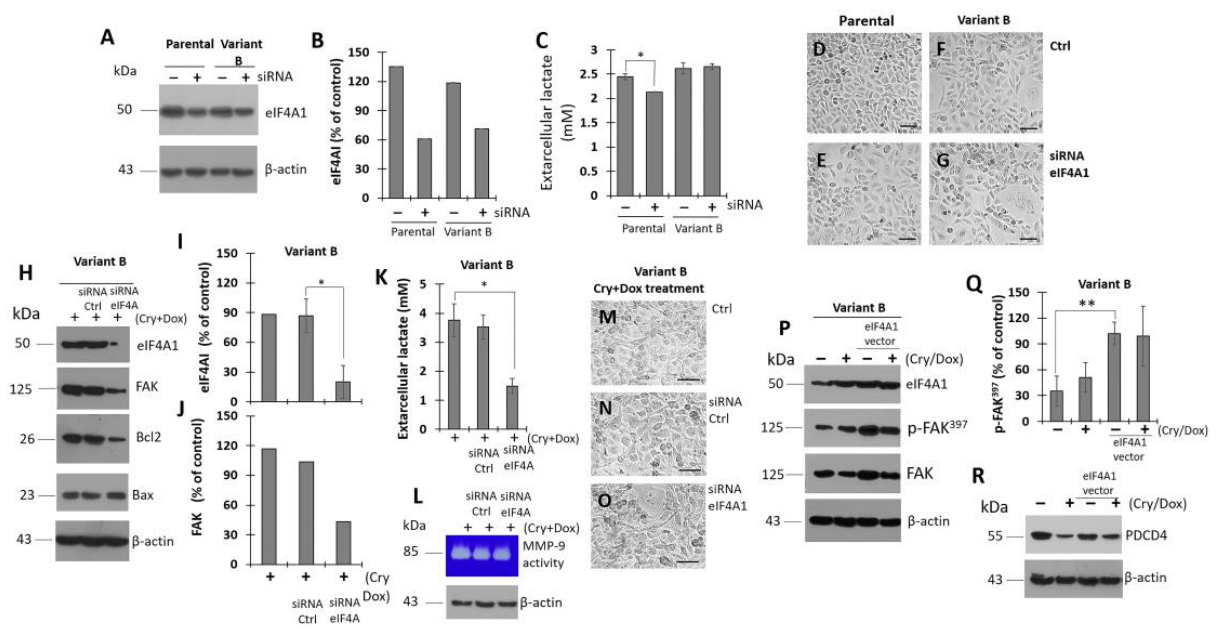
Figure 7. Regulation of eIF4A on FAK is inhibited by concomitant treatment of Dox and Cry. Efficiency of siRNA incubation (80 nM) on the expression of eIF4A1 in parental and variant B at 24 h. ( A ) WB of eIF4A1 in parental cells and variant B and densitometry analysis of eIF4A1 ( B ); ( C ) under the same conditions, lactate concentrations in supernatant media, results are reported as mean ± SD (n = 3), * p < 0.01, respect to control. Optical microscopy images corresponding to control ( D ) and siRNA-eIF4A treated parental cells ( E ); for variant B, control cells ( F ) and siRNA-eIF4A1 treatment ( G ). In controls, the transfection vehicle was evaluated. Bars correspond to 200 µ m. ( H ) Effect of siRNA-eIF4A1 on the expression of FAK, Bcl2 and Bax under the concomitant treatment of Cry (25 µ M) and Dox (500 nM) for 60 h in variant B; densitometry analysis of eIF4A1 ( I ) and FAK ( J ), results are reported as mean ± SD (n = 3) and expressed as % of control; * p < 0.01 respect to control. Under the same transfection conditions and concomitant Cry and Dox treatment, evaluation of lactate in supernatant media (* p < 0.01 respect to control) ( K ), MMP-9 activity ( L ), and representative cellular images of control ( M ), siRNA control ( N ), and eIF4A1-siRNA ( O ). Bars correspond to 200 µ m. ( P ) Effect of the eIF4A1 overexpression on FAK expression and activity (p-FAK 397 ) employing an eIF4A1 vector (GenScript, ID: U533ZGE280-1). Results showed the effect of Cry (25 µ M) and Dox (500 nM) treatment for 24 h. ( Q ) densitometry analysis of p-FAK 397 , results are reported as mean ± SD (n = 3) and expressed as % of control; ** p < 0.05 respect to control. ( R ) Under the same conditions, WB of factor PDCD4. In panels A, H, L, P, and R, β -actin was used as a loading